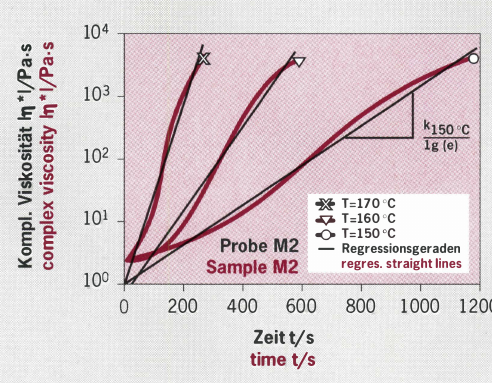
Abb. 7: Reaktionskennwerte in Abhangigkeit der rezipro­ ken Temperatur Fig.l: Reaction constants as a function of the reciprocal temperature